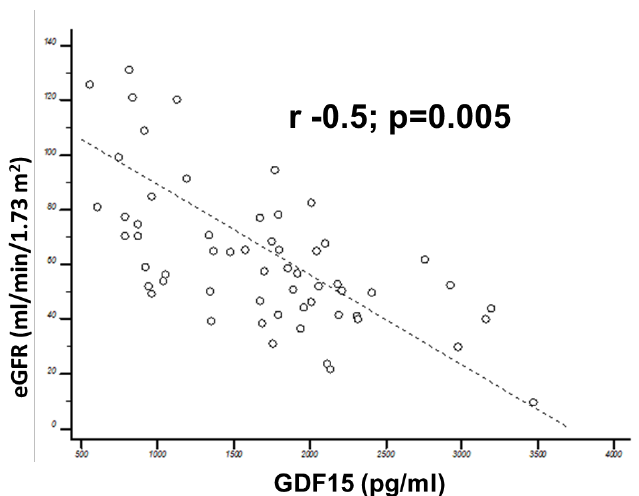
Figure 1. Correlation between Growth differentiation factor 15 (GDF15) and estimated glomerular filtration rate. Note the significant inverse relationship between renal function and GDF-15 levels.